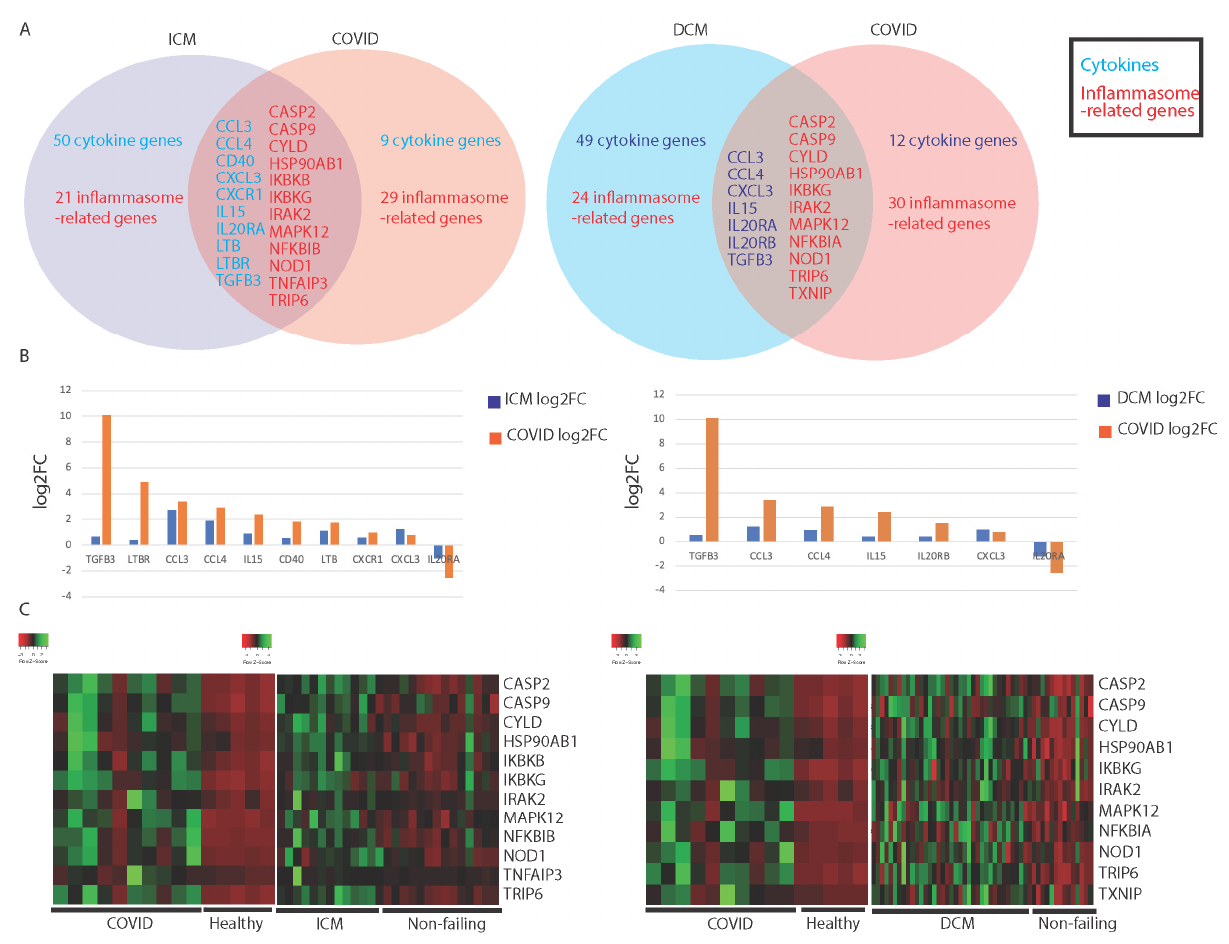
Figure 1. Comparing ischemic cardiomyopathy (ICM), nonischemic dilated cardiomyopathy (NIDCM), and COVID-19 patients. ( A ) Summary of commonly dysregulated cytokine- and inflammasome-related genes in COVID-19 and ICM/NIDCM patients. Cytokines are represented in blue and inflammasome-related genes are in red. ( B ) Bar plots of the log2 fold change of significantly dysregulated cytokine genes in COVID-19 and ICM/NIDCM patients. ( C ) Heatmaps illustrating similar patterns of dysregulation of inflammasome-related genes in COVID-19 and ICM/NIDCM patients compared to their respective controls.